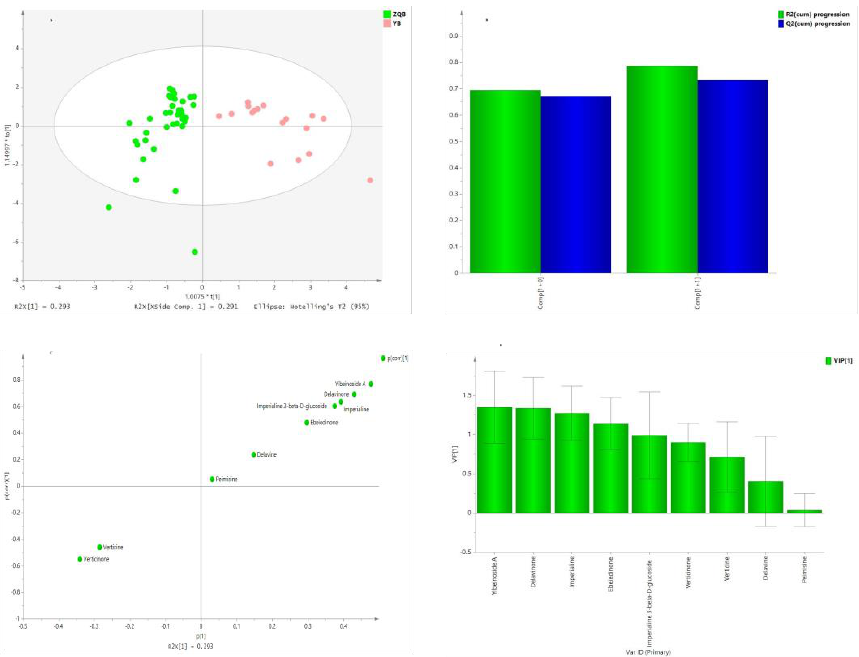
Figure 6. The OPLS-DA of bulbus of FCB (ZQB) and FPB based on the content of nine alkaloids: score plot ( A ), cumulated percentage variation explained by principal components ( B ), S -plots ( C ), VIP ( D ).